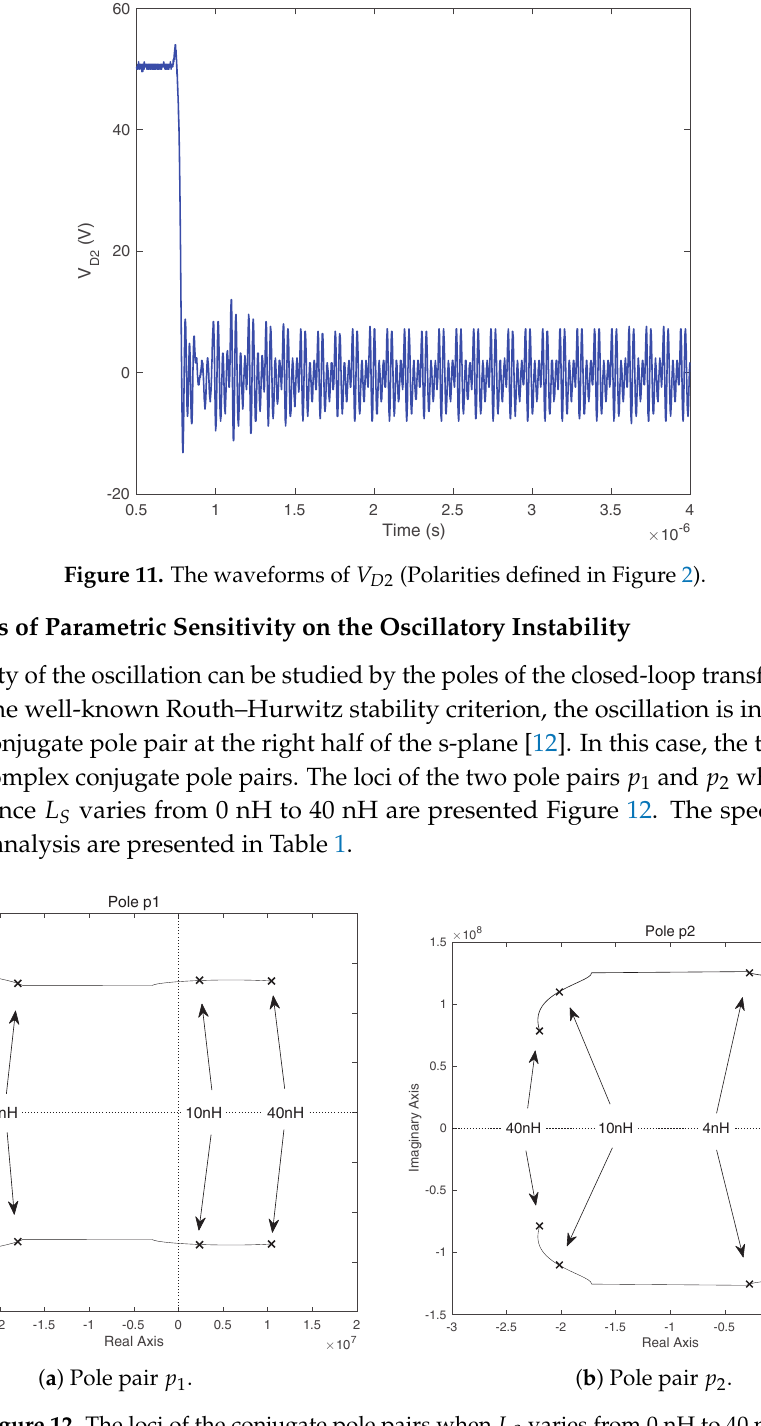
Figure 12. The loci of the conjugate pole pairs when L S varies from 0 nH to 40